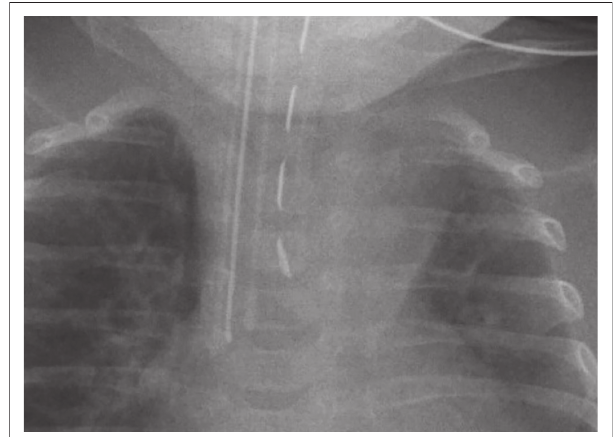
FIGURE 15: Reploggel tube with dashed line lying in the oesophageal pouch. ET tube lying to the Reploggel suction catheters are used in patients with oesophageal atresia to remove saliva from the blind ending oesophageal pouch. The markings of a Reploggel tube form a dashed line, and help to differentiate it from the ETT (Figure 15).